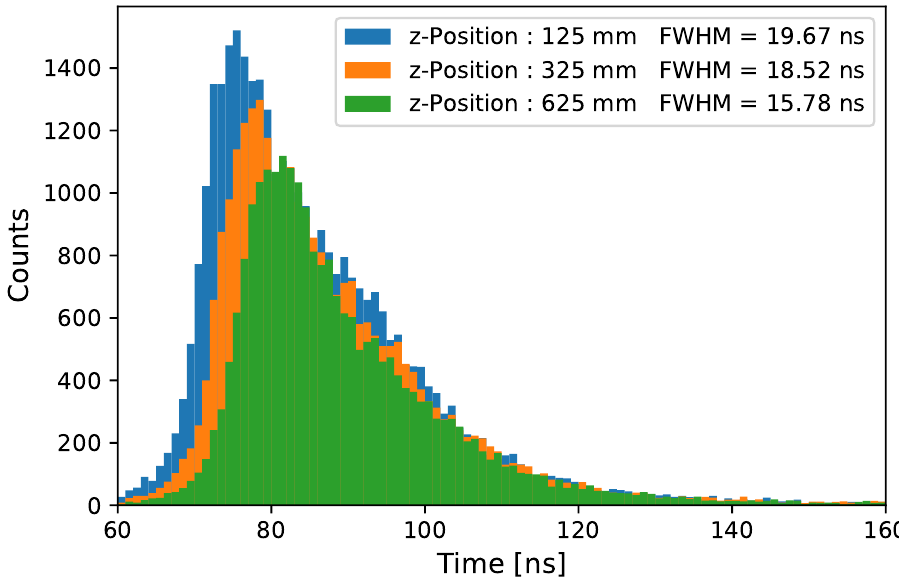
Figure 13. The measured transit time spread of a WOM tube with one attached PMT is shown for different z -positions along the